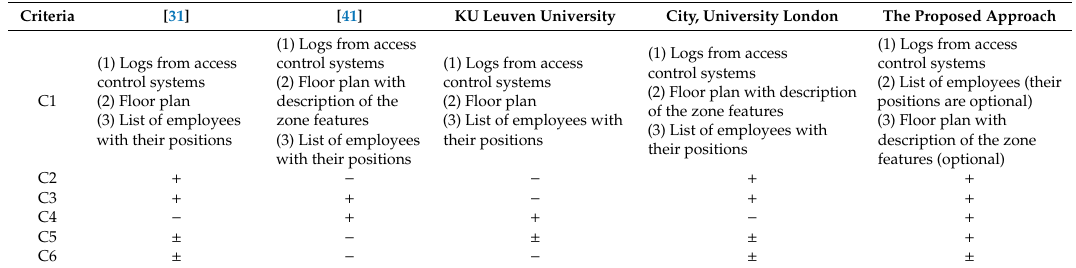
Table 2. Results of the comparison of the suggested approach with other tools.